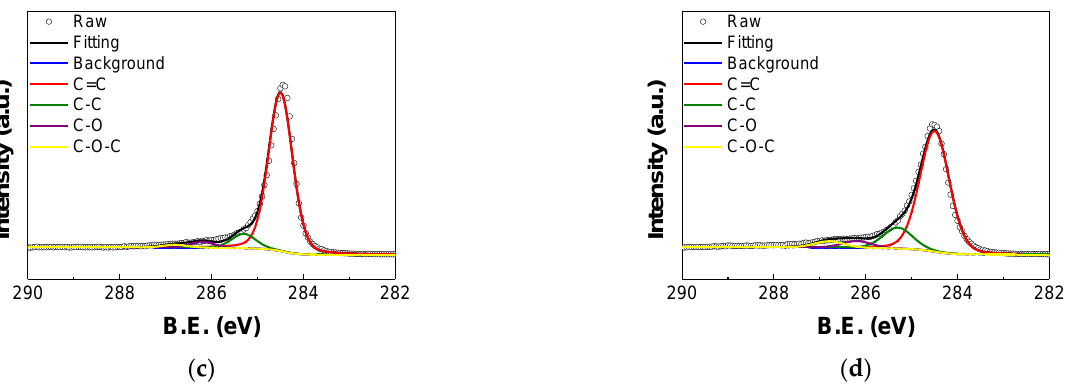
Figure 5. XPS of C1s spectra of graphite foil ( a ) without and ( b – d ) with He DBD jet treatment for ( b ) 30 s, ( c ) 1 min and ( d ) 3 min.